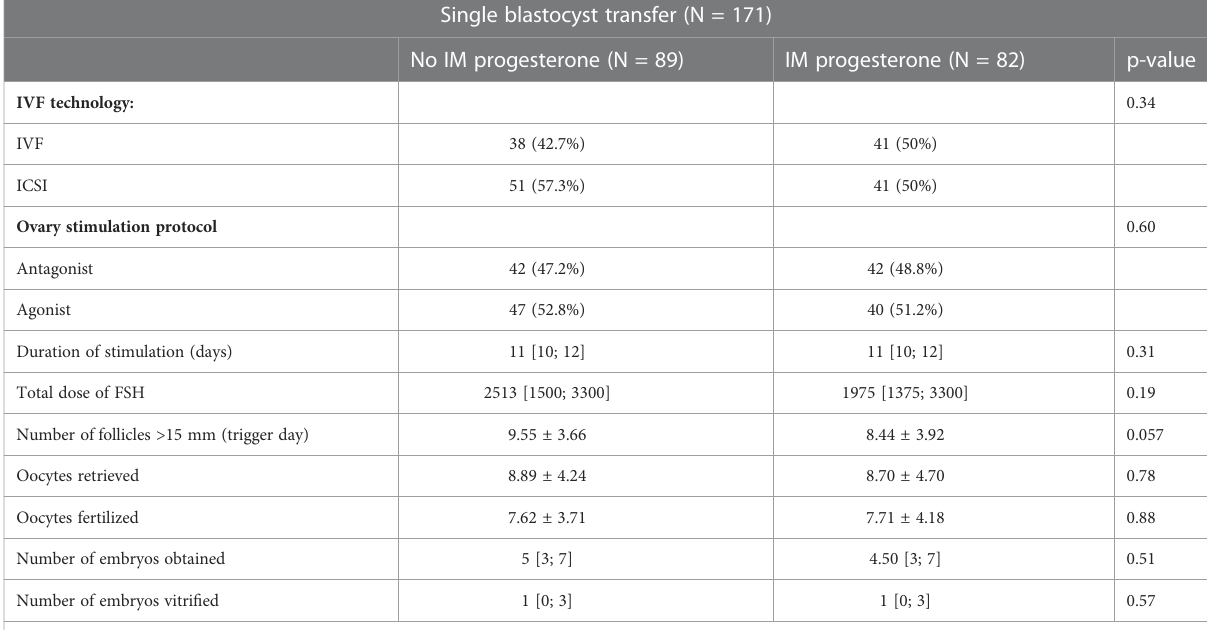
TABLE 2 Characteristics of IVF cycle.